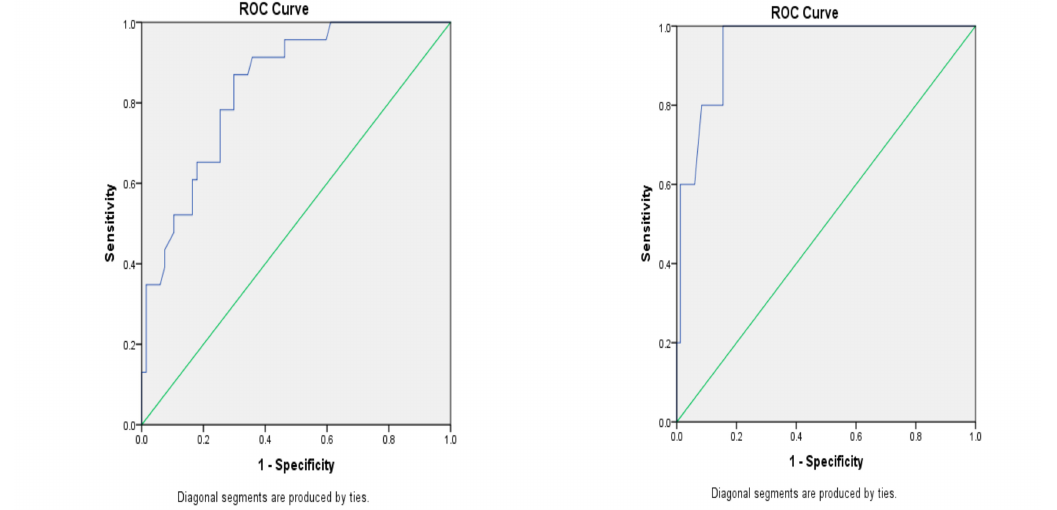
Figure 1. ROC curve with AUC values for all the six regression models.